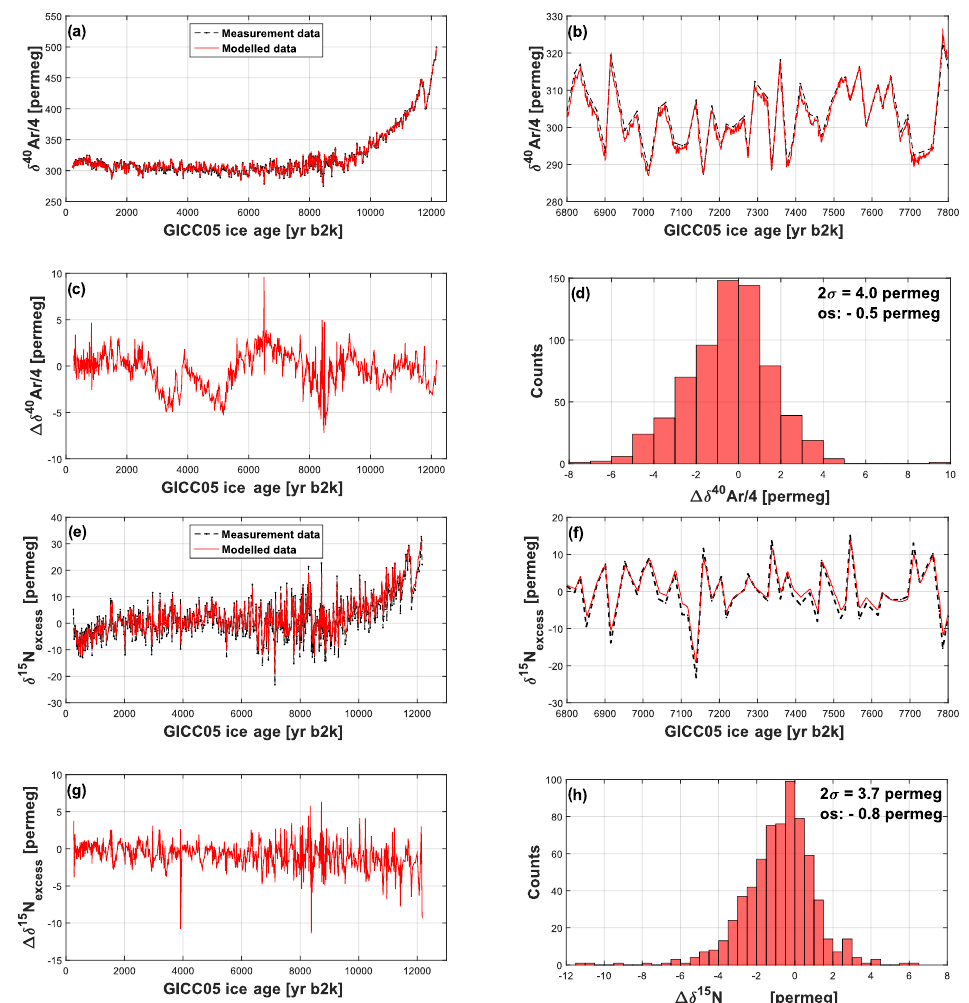
Figure 10. Fitting of GISP2 Holocene δ 40 Ar (a–d) and δ 15 N excess (e–h) data (measurement data from Kobashi et al., 2008b): (a) measured versus modelled δ 40 Ar/4 time series. (b) Zoom-in for the same quantity as in panel (a) . (c) Time series of the final mismatches (cid:49)δ 40 Ar/4 of the measured minus the modelled δ 40 Ar/4 data. (d) Histogram for the same quantity as in panel (c) showing an overall final mismatch (2 σ ) of 4.0permeg and offset (os) of − 0.5permeg. (e) Measured versus modelled δ 15 N excess time series. (f) Zoom-in for the same quantity as in panel (e) . (g) Time series of the final mismatches (cid:49)δ 15 N excess of the measured minus the modelled δ 15 N excess data. (h) Histogram for the same quantity as in panel (g) showing an overall final mismatch (2 σ ) of 3.7permeg and offset (os) of −